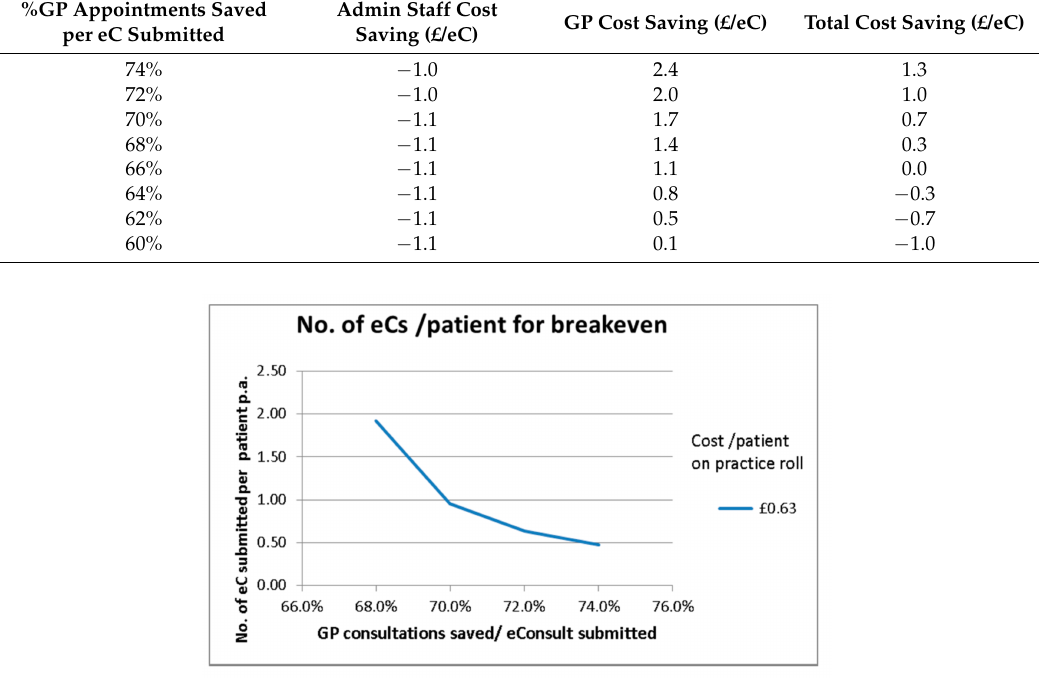
Figure 10. The number of eConsults /patient required versus % of consultations saved for